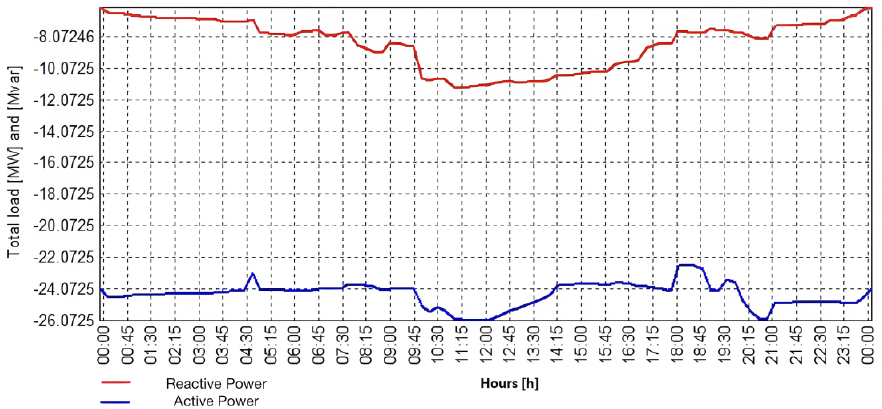
Figure 24. Active and reactive power at feeder